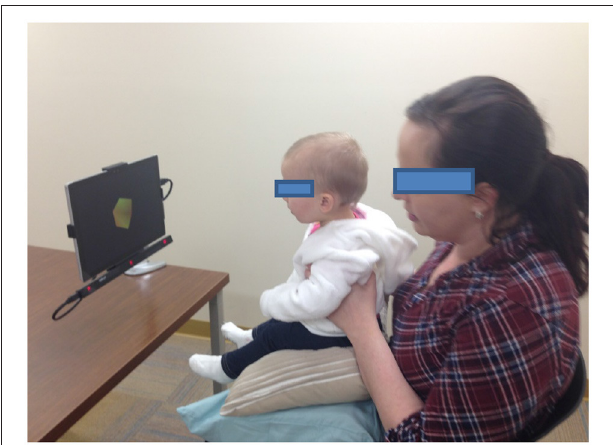
FIGURE 2 | A prototype of the Developmental Cognitive Profiler, designed to assess cognition in infants and toddlers by recording gaze in response to animated sequences. Infants are seated on their parent’s lap ∼ 60cm from the tablet. Parents wear infrared